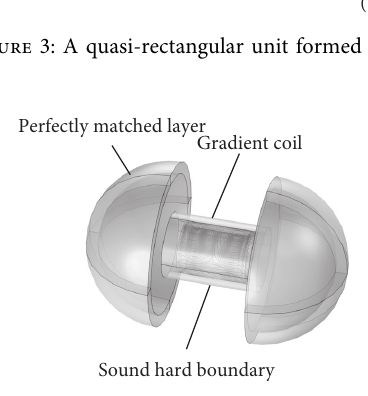
Figure 4: The constructed model for the evaluation of noise level. The gradient coil was surrounded by a cylindrical surface modelled with sound hard boundary. Two hemispheres flush with the cyl- inder end were added to model perfectly matched layers.